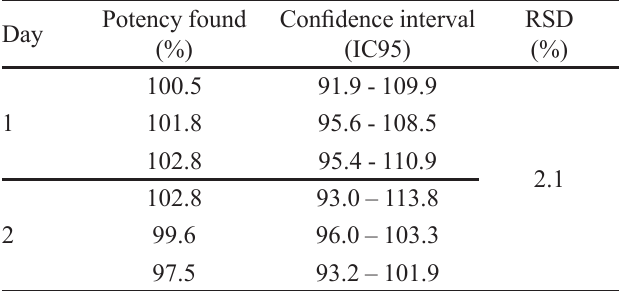
TABLE III - Between-day precision data of the CFTX bioassay.